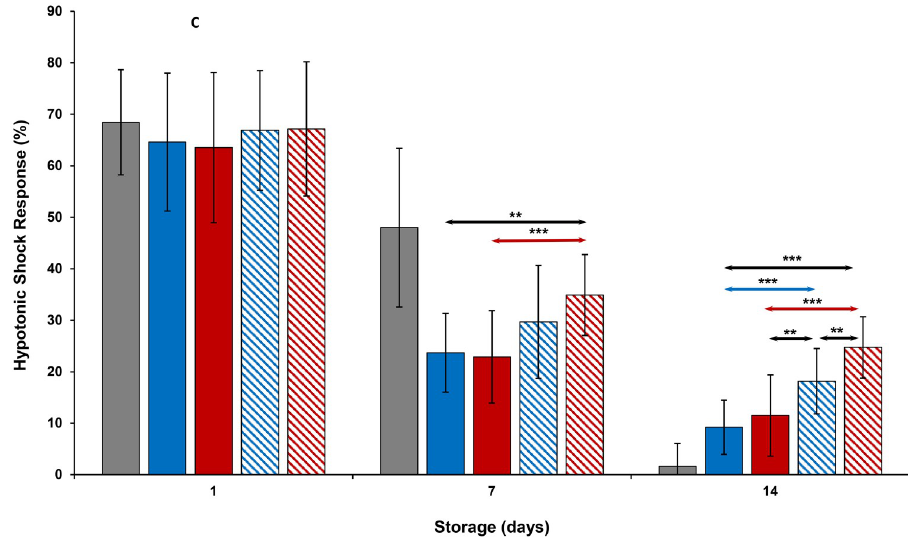
Fig 3. Effects of 14-day storage, temperature and presence of p38MAPK inhibitor on platelet hypotonic shock response. Grey bar–platelets stored at room temperature; blue solid bar–cold-stored platelets; red solid bar– thermocycled-stored platelets; blue striped bar–cold-stored + VX-702 platelets; red striped bar–thermocycled-stored + VX-702 platelets. Data represents the mean of 15 experiments with one standard deviation. Arrows represent paired statistical differences; �� —p < 0.01, ��� —p <